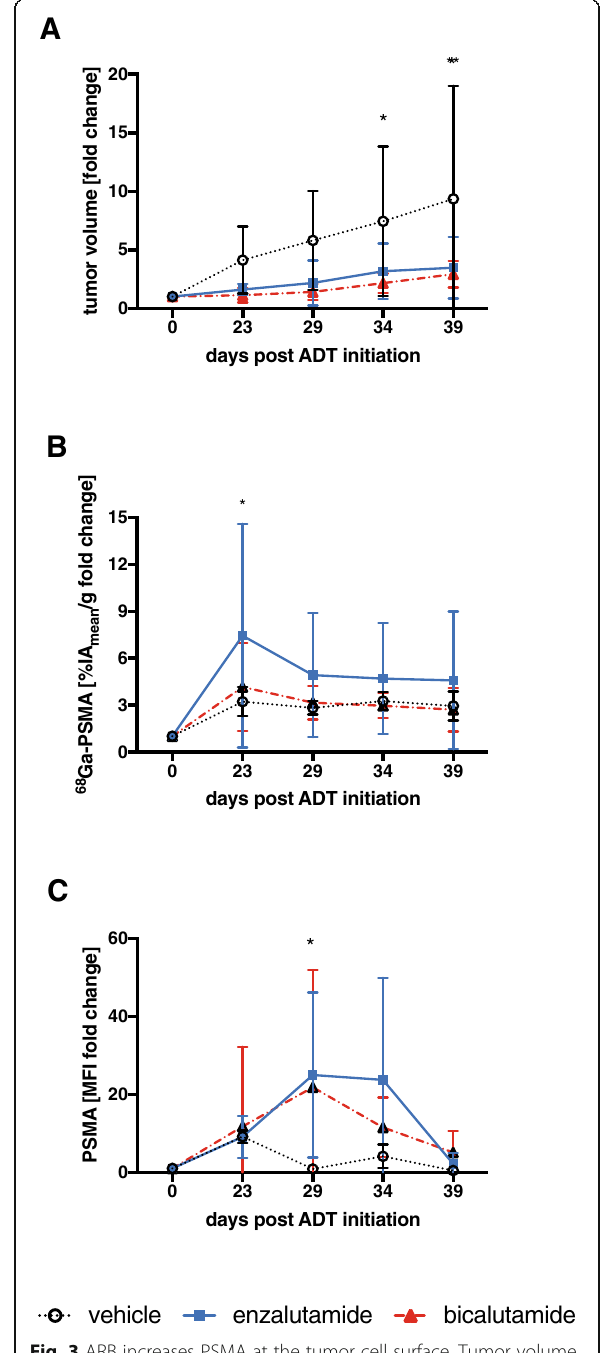
Fig. 3 ARB increases PSMA at the tumor cell surface. Tumor volume of C4-2 ( a ) tumors was determined by CT (ENZ vs. vehicle, p = 0.05; BIC vs. vehicle, p = 0.02). 68 Ga-PSMA11 PET signal (%IA mean /g) in C4-2 ( b ) tumors (ENZ vs. vehicle, p = 0.02; BIC vs. vehicle, p = n.s.). PSMA mean fluorescent intensity (MFI) is shown for each group (ENZ vs. vehicle, p = 0.03; BIC vs. vehicle, p = n.s.) ( c ). The fold-change during ARB treatment, related to the pre-treatment volume is shown. Data are shown as mean ± SD. Asterisks indicate significance